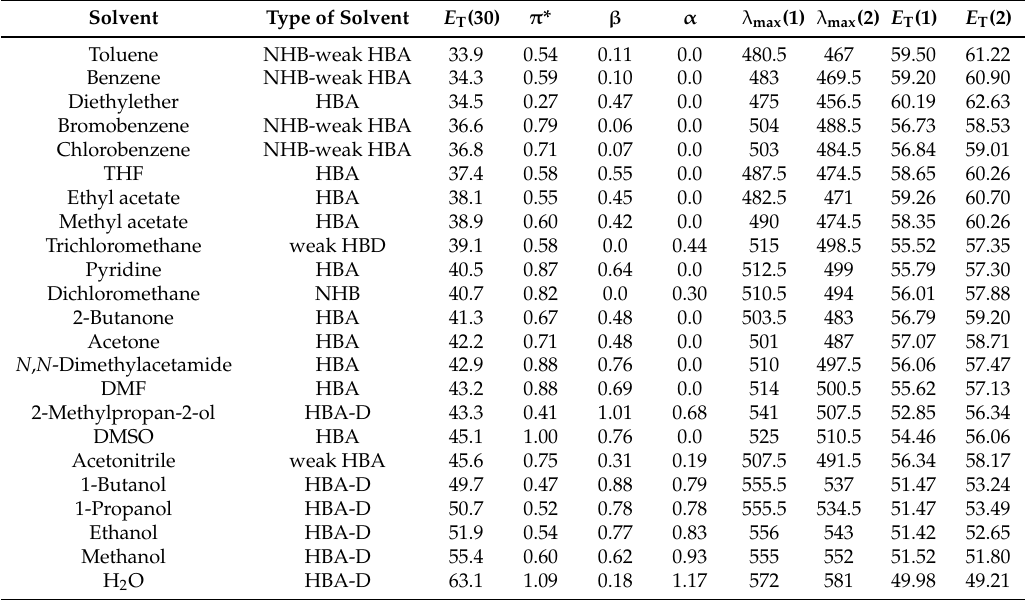
Table 4. Solvatochromic parameters π *, β and α [23,24] E T (30) [25] of studied solvents, and λ max (nm) and E T (kcal · mol − 1 ) of compounds 1 and 2